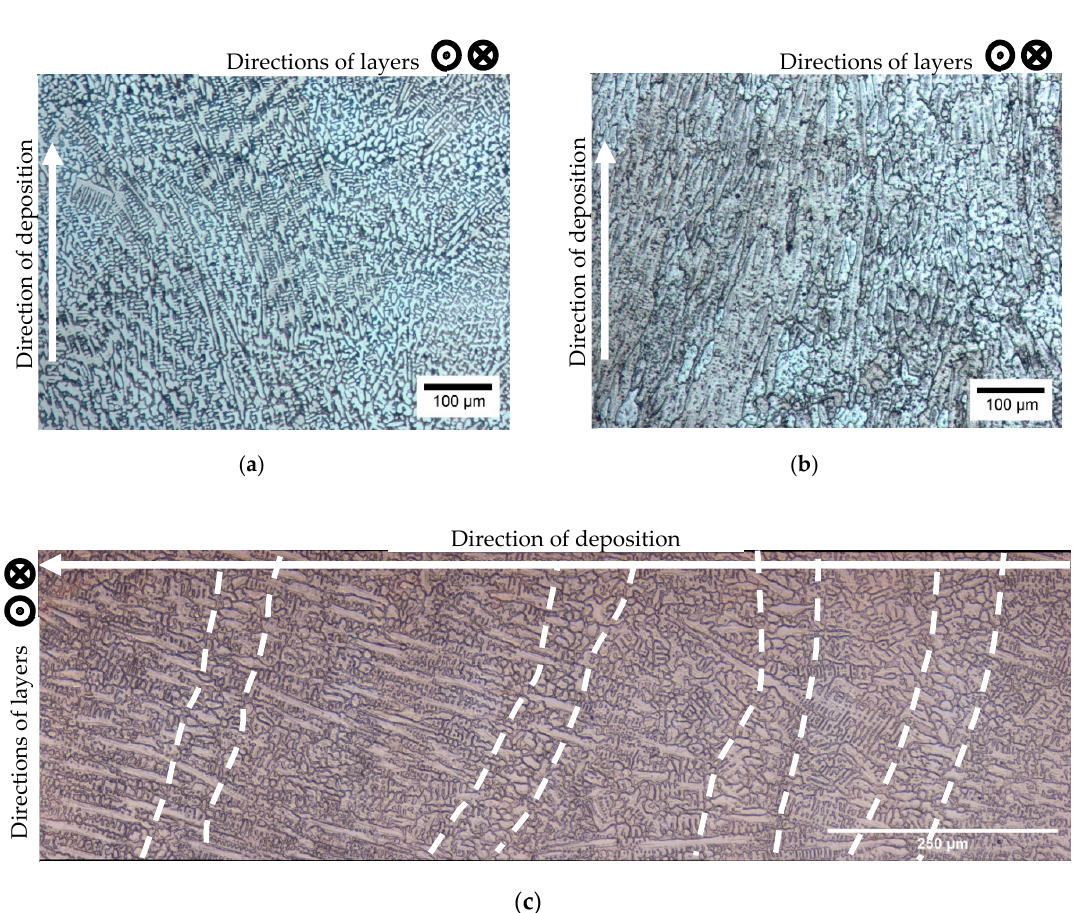
Figure 6. Optical microscope images of transverse sections of ( a ) the 100/0 nickel-rich deposit and ( b ) the 30/70 copper-rich deposit ( c ) bands of coarsened dendrites on 100/0 deposits, suspected to originate from remelting during successive layer-by-layer deposition.